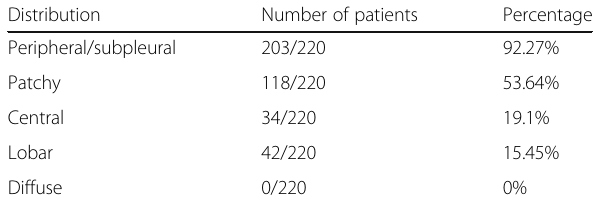
Table 3 The distribution of lesions in